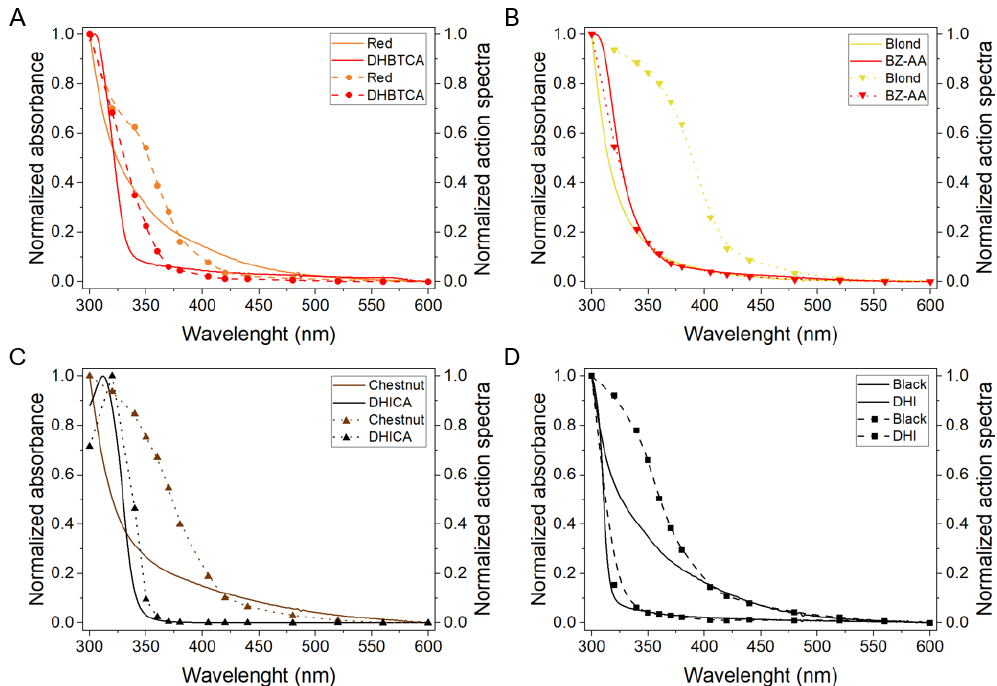
Figure 9. Absorption spectra of melanin nanoaggregates obtained from different hair and of selected melanin monomer units, and their corresponding action spectra of oxygen photogeneration for: red hair and BT monomers (A), blond hair and BZ monomers (B), chestnut hair and DHICA monomers (C), and black hair and DHI monomers (D). Solid lines depict absorption, whereas dashed lines with symbols characterize melanin monomer units.